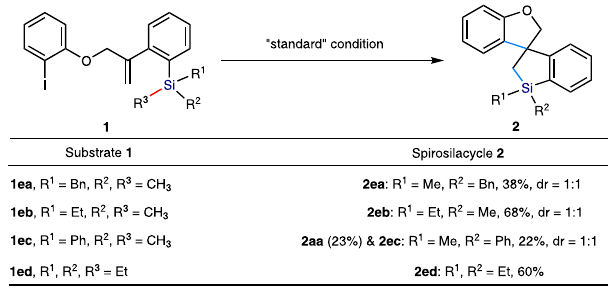
Fig. 3 | Investigation into the reactivity of the substituents on the silicon center. Reactionswerecarriedoutbyusing [Pd] − 1 (0.01mmol),LiO t Bu(0.6mmol), AgOAc (0.4mmol), CuTc (0.04 – 0.2mmol), and 1 (0.2mmol) in Cyclohexane (0.4M)orToluene(0.4M)for4 – 12h.Isolatedyieldsareshown.Thediastereomeric ratio(dr)ofproduct 2 wasdeterminedby 1 HNMR.Bothofisomerswereisolatedby